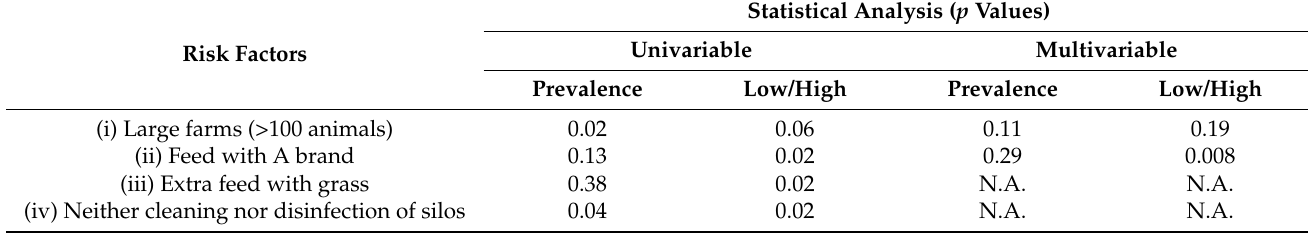
Table 3. Risk factors associated with salmonellosis in free-range pigs. The prevalence of Salmonella on the farm was considered to be a continuous variable or as a categorical variable considering the cut-off of 20% prevalence (low or high prevalence on farms with presence of Salmonella spp. in less than or more than 20% of pigs, respectively). The analysis of the prevalence as a continuous variable or as a categorical was carried out by a multivariable regression or logistic analysis, respectively.